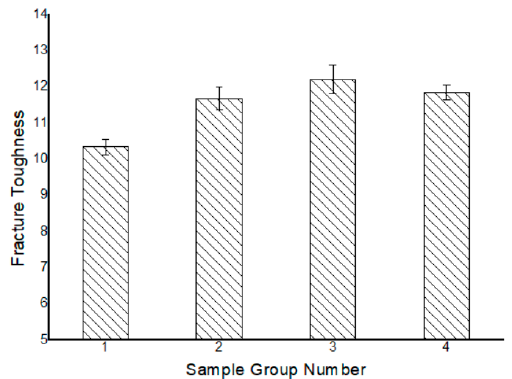
Figure 5. Fracture toughness of WC–Co cemented carbide.